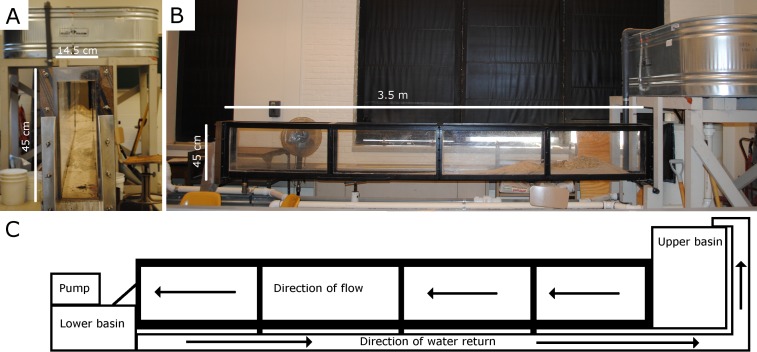
Recirculating flume facility at UW Oshkosh where experiments were conducted.(A) Cross-sectional view, (B) Side view, (C) Schematic diagram of recirculating flume.